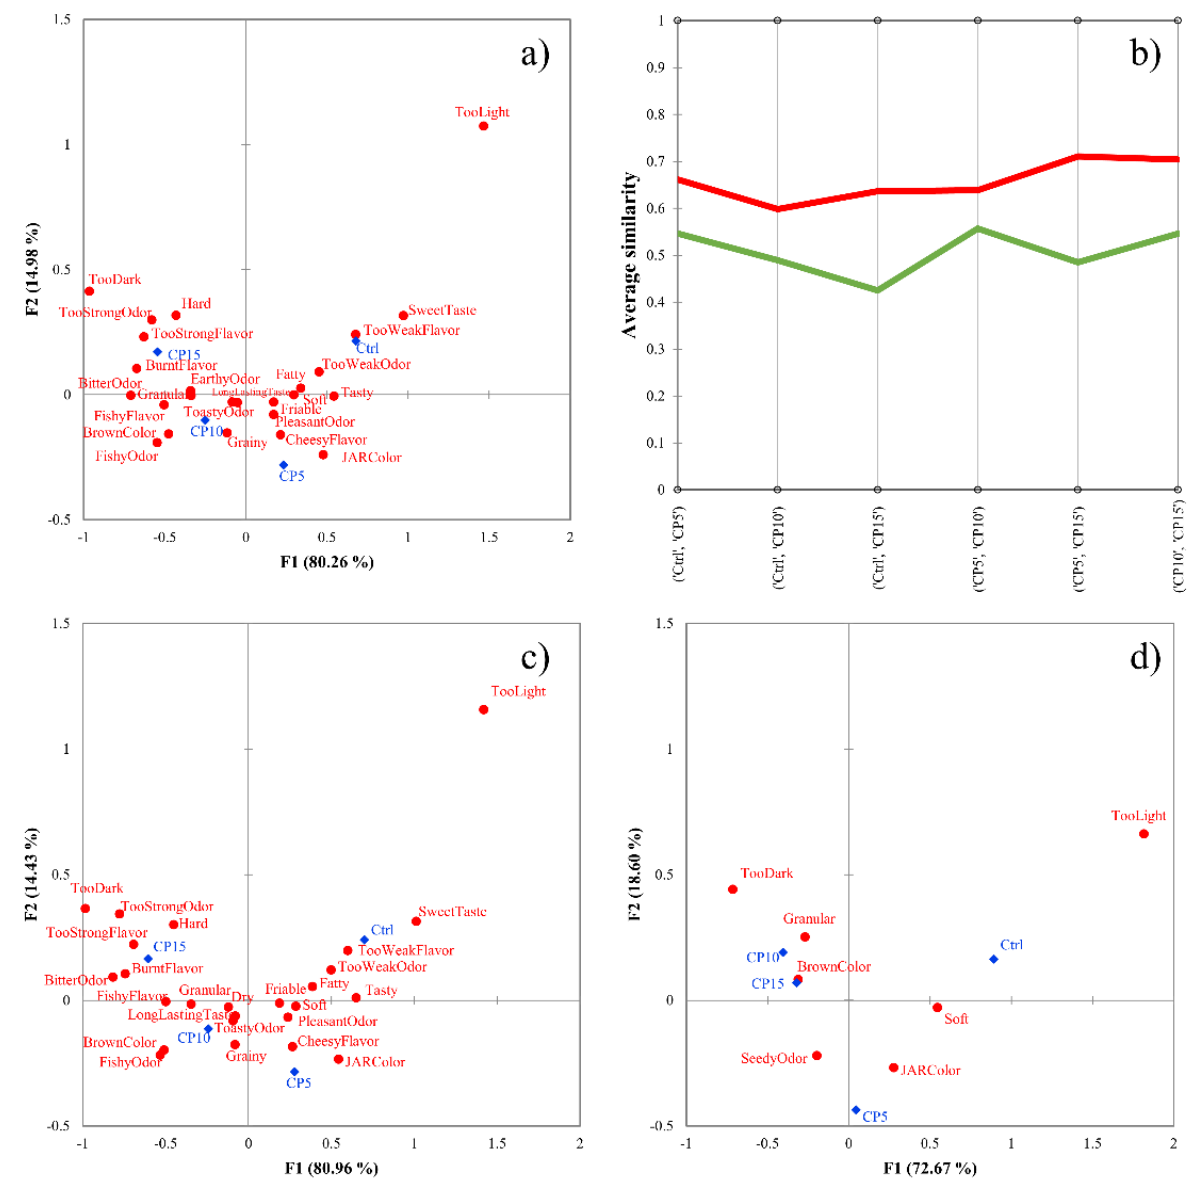
Figure 3. ( a – d ) Results of the cricket-enriched biscuit dataset. Correspondence analysis of the total sample (n = 67). ( a ), profile plot of the agglomerative hierarchical cluster analysis with Euclidean distance and Ward’s method ( b ), correspondence analysis of good discriminators (n = 56) ( c ), correspondence analysis of poor discriminators (n = 11) ( d ). Products are marked with blue dots, attributes are marked with red squares in panels ( a , c , d ), cluster of good discriminators is colored by green, while poor discriminators are colored by red in panel ( b ). Samples contained 0% (Ctrl), 5% (CP5), 10% (CP10), and 15% (CP15) cricket powder.